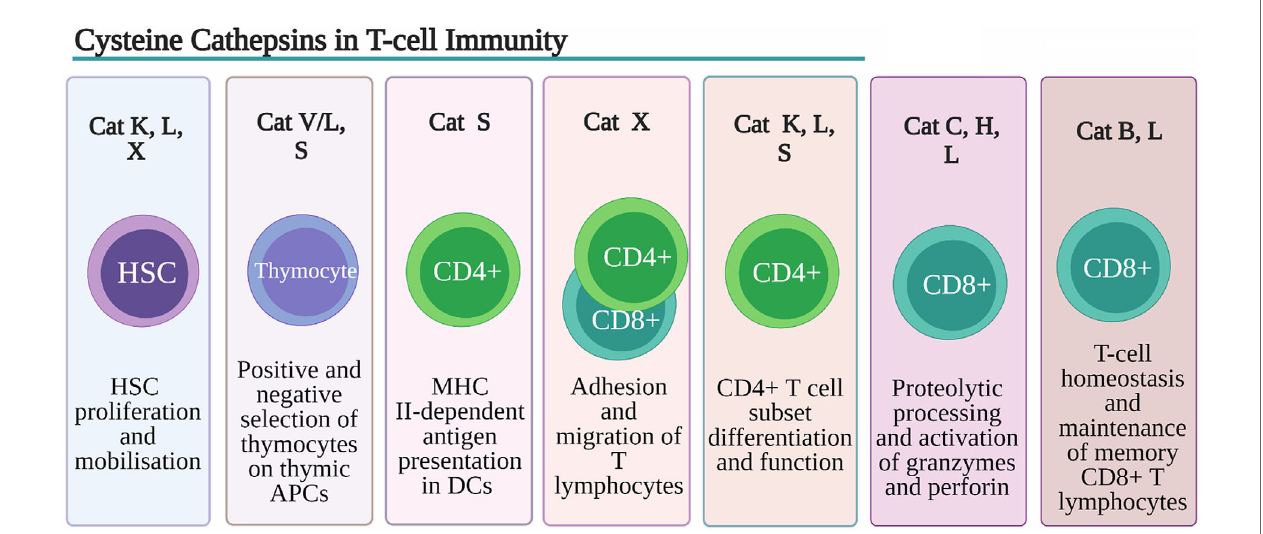
TABLE 1 | The role of cysteine cathepsins in immune cell development and homeostasis. Immune cell development Bone Osteoblast (67) secreted Cathepsin K degrades type I collagen (60), osteopontin, and CXCL12 (65). marrow Cathepsins B, L, and X digest CXCL12 in vitro (67). Cathepsin L is involved in activation of heparanase (64). Cathepsin K is required for osteoclast engagement in response to the microenvironmental stimuli (59). Cathepsin K derived from HSC supportive stromal cells (68, 69) affects LSK cell colony formation and proliferation in vitro and their repopulating activity and maintenance of lymphopoiesis in vivo (70). In vitro , TLR9 signaling promotes caspase-independent cell death via a cathepsin B-dependent mechanism in pro-B cells (71). Thymus Cathepsin L is critical MHC class II-mediated peptide presentation, acting both in Ii degradation (72) and in the generation of MHC class II-bound peptide ligands presented by thymic cortical APCs in mice (73). Cathepsin V expressed in thymic cortical APCs in human thymus, participates in Ii processing (74) Cathepsin S in human thymic DCs, is involved in negative selection/elimination of autoreactive T cells (75). Cathepsin L is critical for CD1d presentation to NKT cells in vitro and their selection in vivo (76). Cathepsin L is critical for maturation of NKT cells (77). Immune cell homeostasis Cathepsins B and L activities are essential for T lymphocyte apoptosis in response to high concentration of antigen in vitro (78, 79). Cathepsin B pro-apoptotic activity limits the long-term maintenance of memory CD8+ T cell populations (80). Cathepsins B and L are essential for antigen-dependent germinal center B cell death (81). Cathepsin B was identi fi ed as a negative feedback regulator of lysosomal biogenesis and autophagy (82). Cathepsin H, trough cleavage of talin (30) could be involved in maintaining the homeostasis and survival of the regulatory T (Treg) cell pool (83). Pro- and mature forms of cathepsin X interact with b 2 integrin receptors, thus modulating their af fi nity for extracellular ligands (84). CXCL12, C-X-C motif chemokine 12; HSC, Hematopoietic stem cells; NKT, Natural killer T cells; TLR9, Toll-like receptor 9; MHC, major histocompatibility complex molecules; Ii, invariantchain; APC, antigen presenting cell; LSK Lineage - Sca + Kit + cells; dendritic cells; (DCs), dendritic